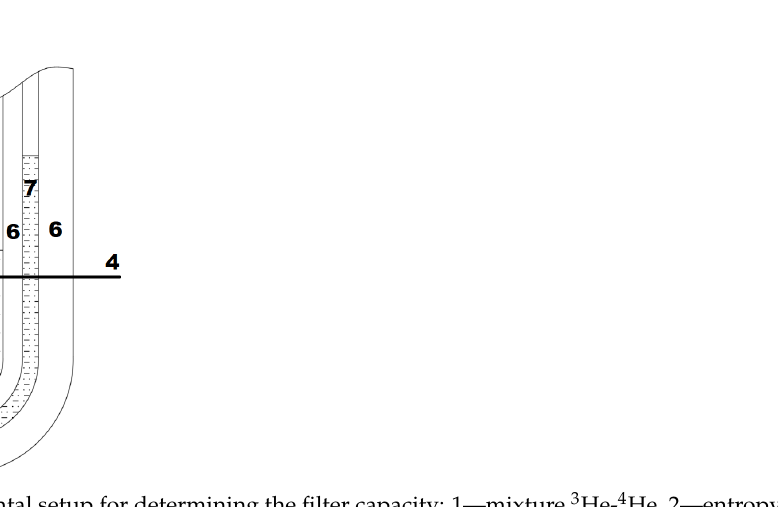
Figure 3. Experimental setup for determining the filter capacity: 1—mixture 3 He- 4 He, 2—entropy filter, 3—vessel for 4 He, 4—heater, 5—recovery of 4 He, 6—vacuum, 7—vessel of liquid nitrogen.